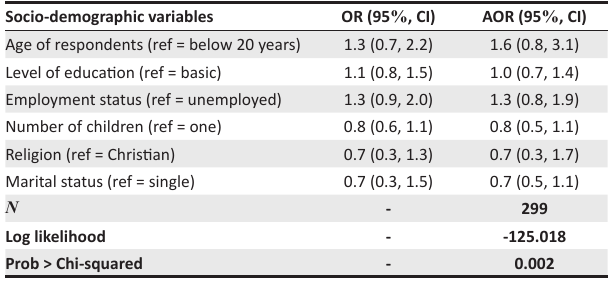
TABLE 4: Results of logistic regression analysis of socio-demographic factors influencing immunisation. Socio-demographic